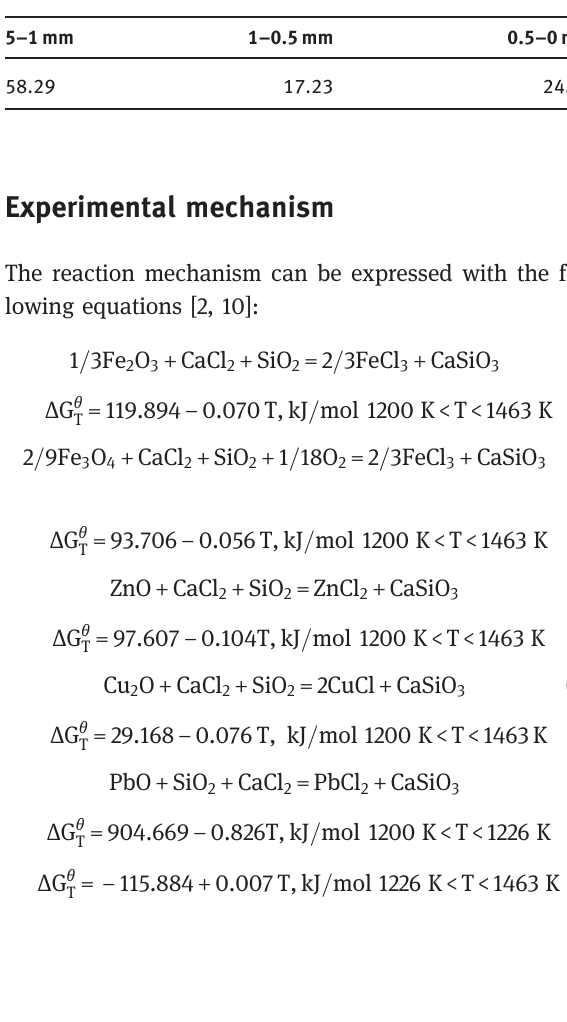
Table 4: Particle size of bituminous coal (mass/%).